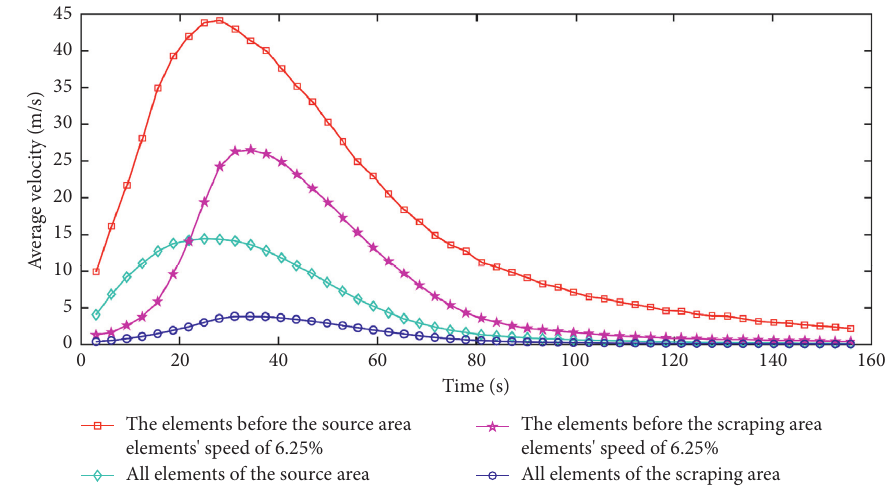
The elements before the source area elements' speed of 6.25% All elements of the source area Figure 9: Curve of average velocity of the source area and the scraping area elements.